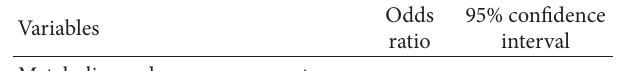
Table 3: Multiple logistic regression analysis for nonmetabolic syndrome (NMS), metabolic syndrome A (MSA), and metabolic